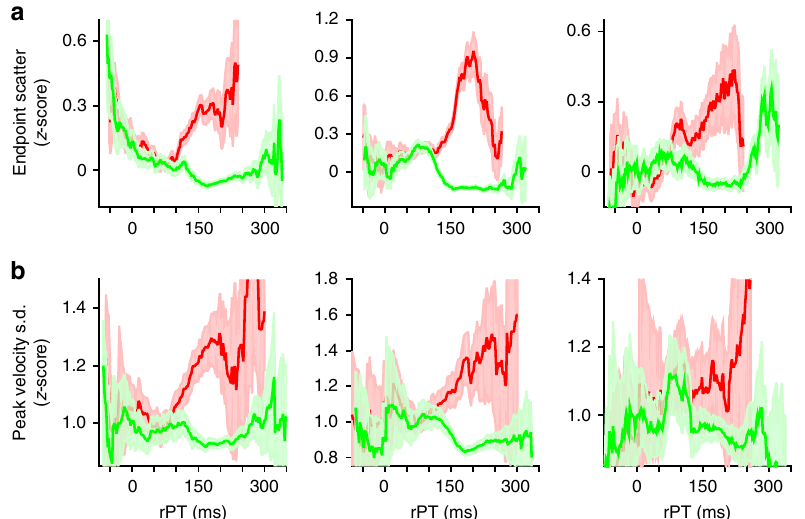
Fig. 6 Perceptual information modulates the variability of saccade metrics. a Mean saccade endpoint scatter (±1 s.e.m.) of correct (green) and incorrect (red) saccadic choices as a function of rPT. b Mean standard deviation (s.d.) of normalized ( z -scored within each session) peak velocity measures for correct (green) and incorrect (red) saccadic choices as a function of rPT. Error bars in b represent 95% con fi dence intervals. Data are from monkeys R, T, and G (left to between the amplitudes and peak velocities of uninformed saccades (rPTs < 75). This measure of saccade vigor — rpv — quanti fi es peak